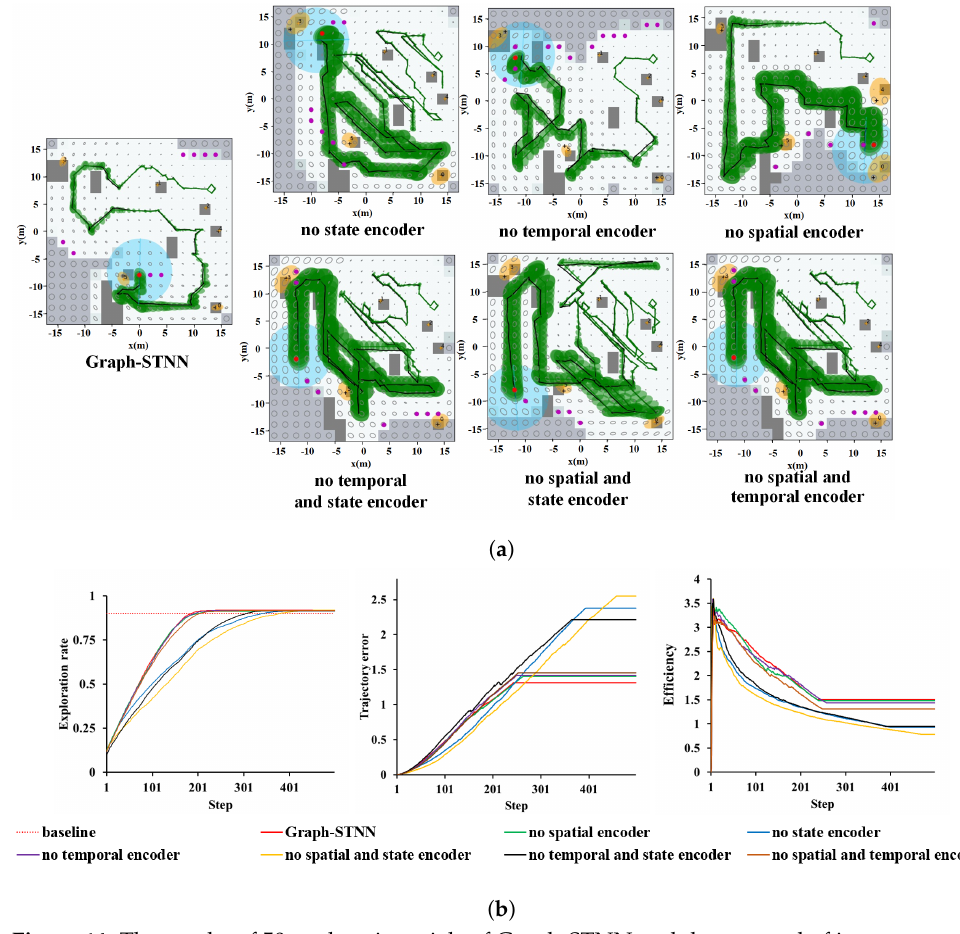
Figure 14. The results of 50 exploration trials of Graph-STNN and the removal of its components, with the model trained in 20 m × 20 m maps and the same initialized landmarks and robot’s start locations, on 30 m × 30 m maps. ( a ) One of the test result of 50 exploration trials. ( b ) Average exploration rate (left), trajectory error (middle), and exploration efficiency (right). Table 3. The trajectory error and exploration efficiency of Graph-STNN and its removal of some components with the size of 20 m × 20 m, 30 m × 30 m and 40 m × 40